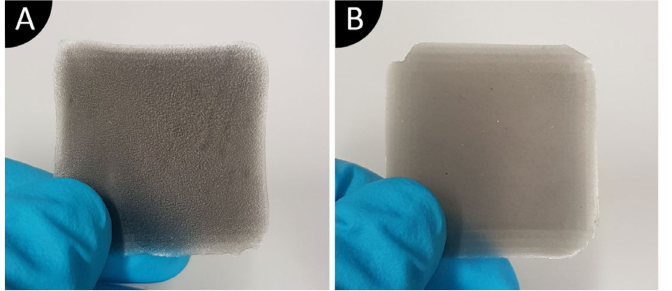
Figure 5. The difference in the top surface quality of cured specimens: ( A ) MWFE (rough top surface); ( B ) MWFI (smooth top